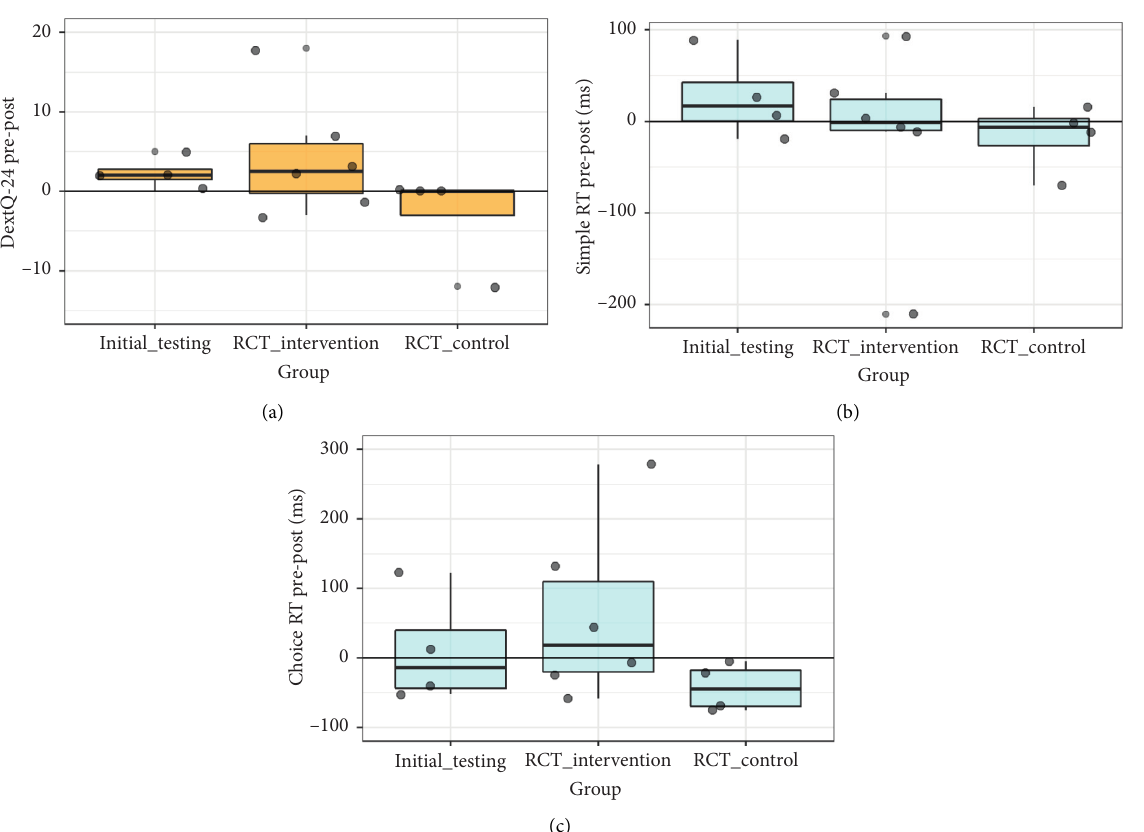
Figure 5: Changes in exploratory outcome measures in the initial testing and pilot RCT: (a) DextQ-24; (b) simple reaction time; (c) choice reaction time. Boxes show medians and quartiles with dots representing individual participants. Positive change indicates